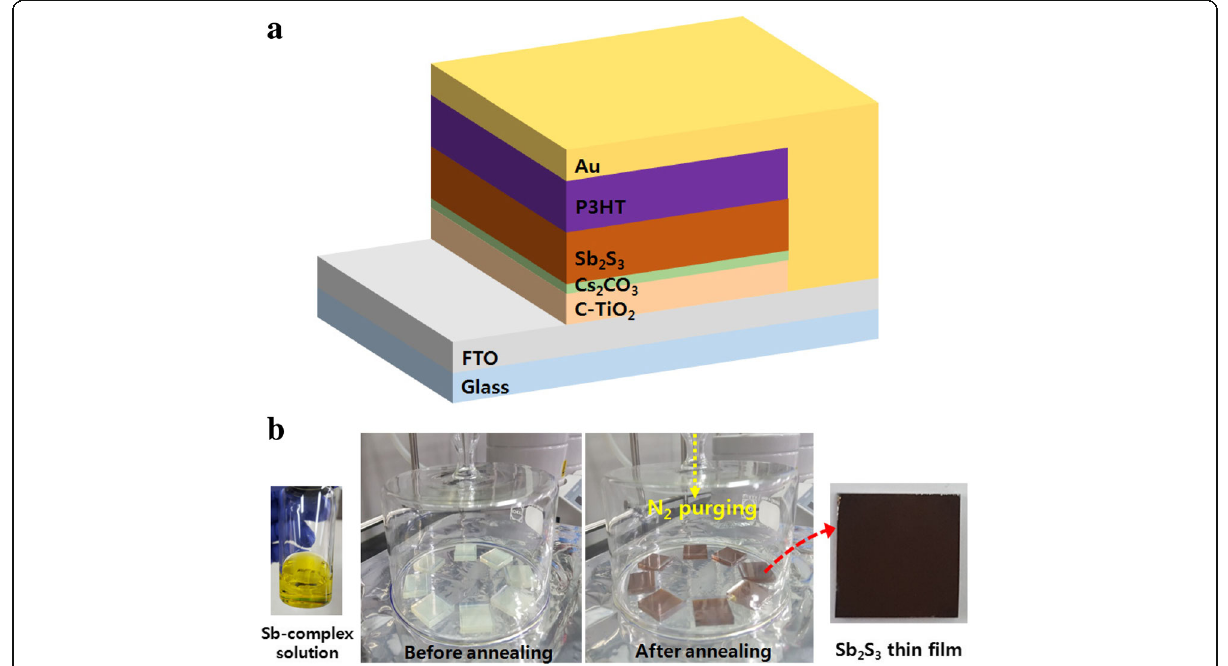
Fig. 1 a Schematic of the device structure of planar-type Sb 2 S 3 solar cells. b Sb 2 S 3 thin film fabrication process using FCA